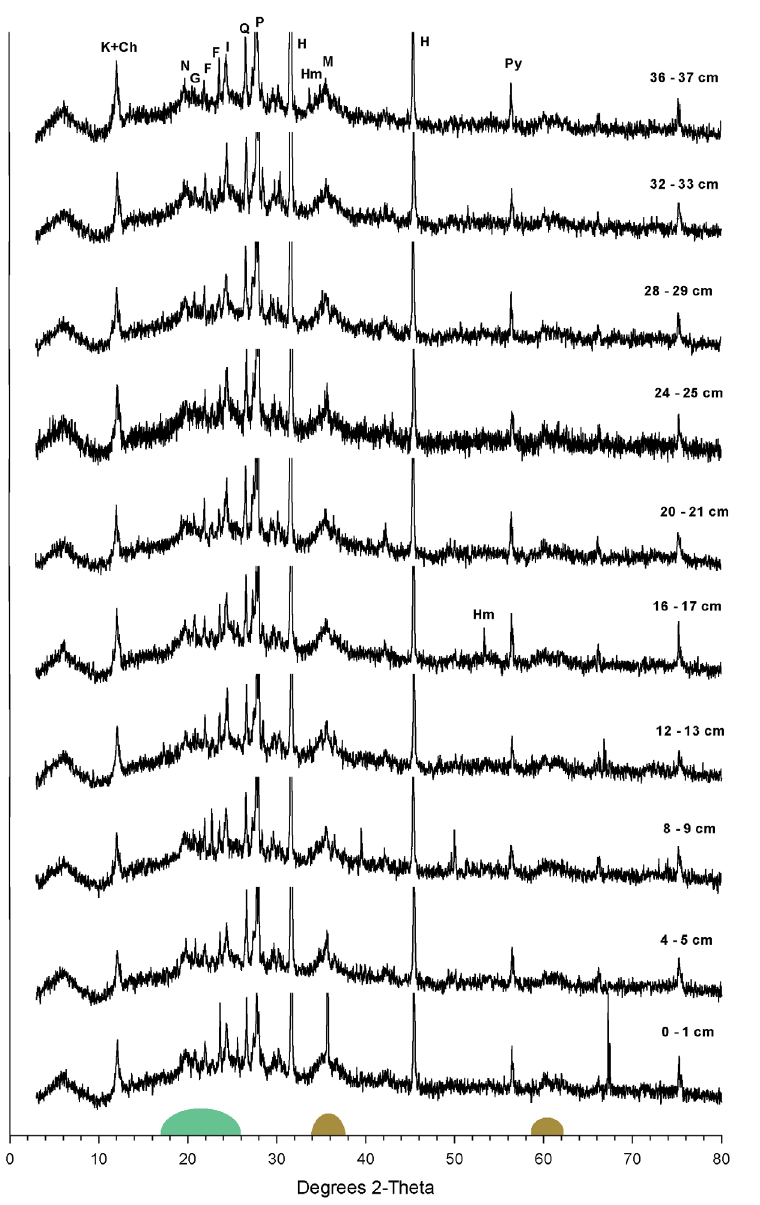
Figure 4. XRD pattern of the sediment core, K—kaolinite, Ch—chlorite, N—nontronite, G—goethite, F—feldspar, I—illite, Q—quartz, P—phillipsite, H—halite, Hm—hematite, M—magnetite, and Py—pyrite. Green shaded area represents amorphous opal, and brown represents poorly crystallized Fe- oxyhydroxide.